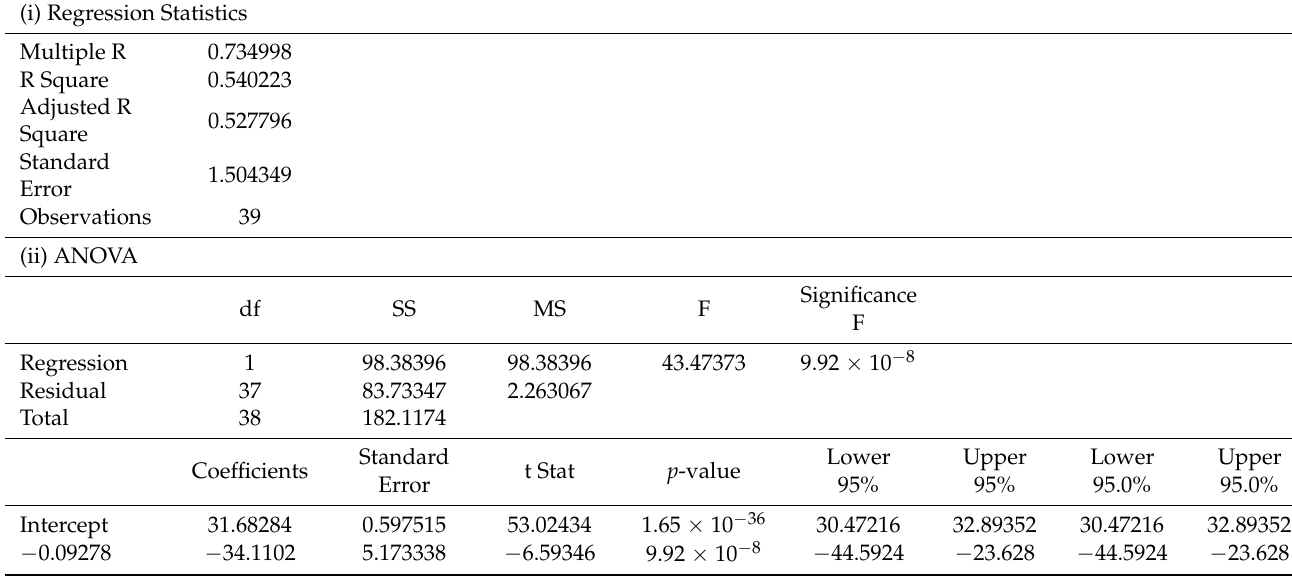
Table A4. Regression Statistics between LST and NDVI for